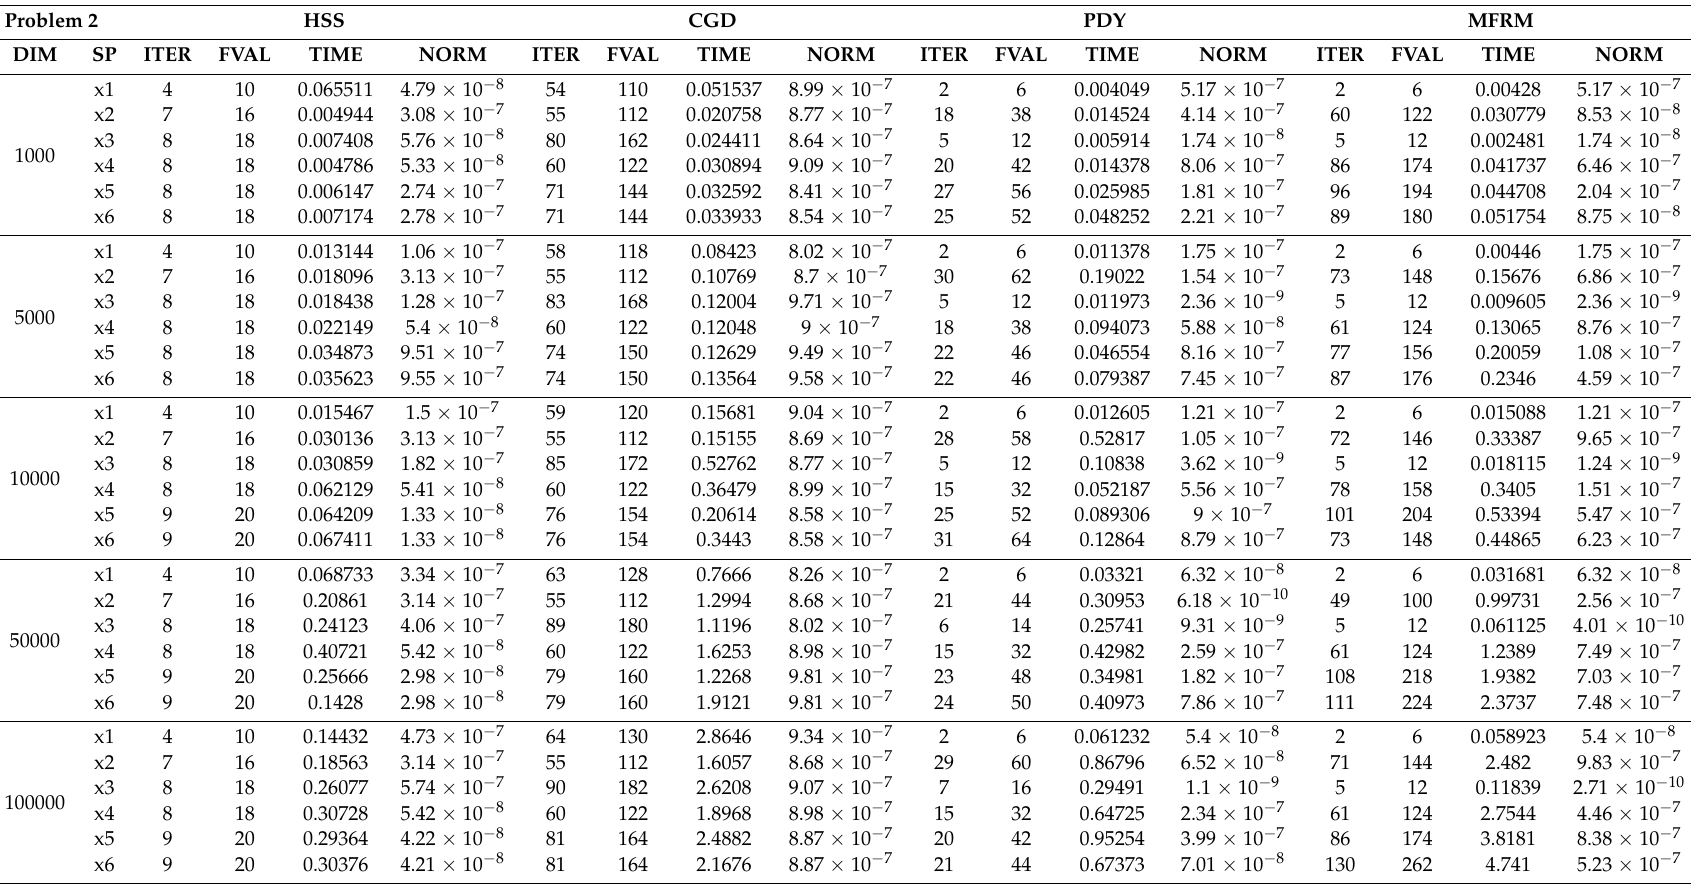
Table 2. Test results obtained by the four solvers for Problem